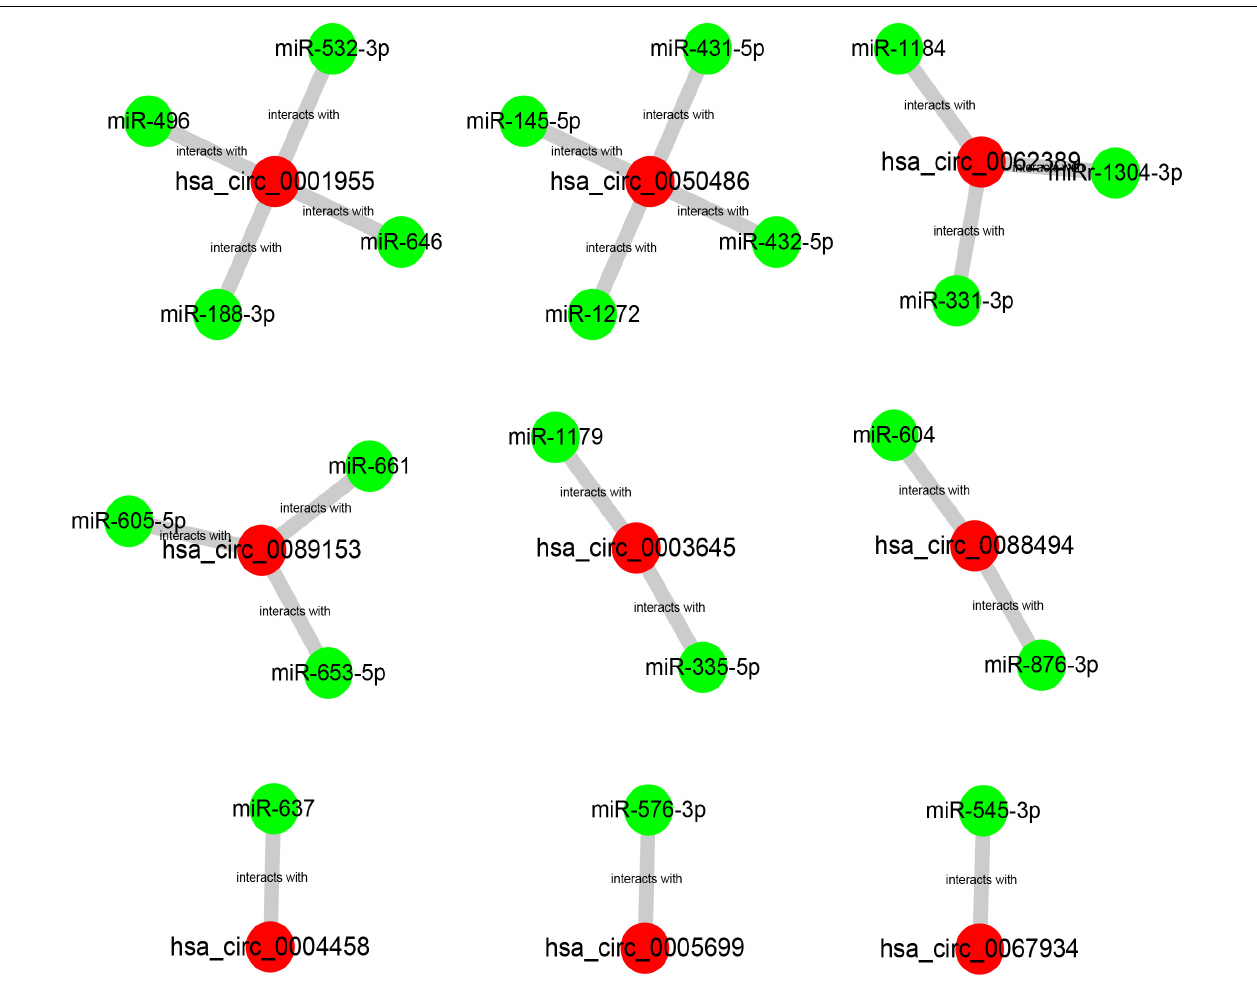
FIGURE 3 | The potential binding miRNAs of 9 circRNAs predicted by CSCD and circular RNA interactome (CRI)